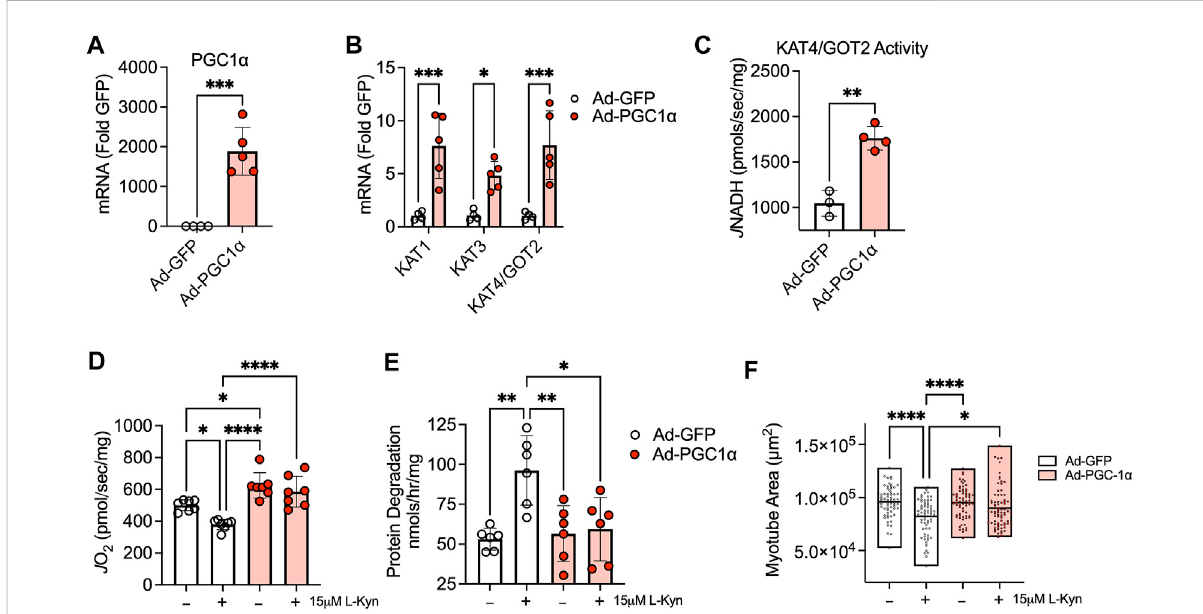
FIGURE 4 Adenovirus-mediated expression of PGC1 α 1 enhances L-Kyn metabolism and protects myotubes for atrophy and mitochondrial de fi cits. (A) Quanti fi cation of mRNA levels of PGC1 α in myotubes infected with adenovirus encoding a GFP (control) or PGC1 α . (B) Ad-PGC1 α expression increased mRNA levels of cytosolic (KAT1 and KAT3) and mitochondrial (KAT4/GOT2) kynurenine aminotransferases. (C) Enzyme activity of KAT4/ GOT2 measured in mitochondrial-enriched lysates from infected myotubes. (D) Mitochondrial oxygen consumption ( J O 2 ) supported by pyruvate, malate, and ADP. (E) Rates myotube protein degradation (tyrosine release) with L-Kyn treatment was prevented Ad-PGC1 α . (F) Quanti fi cation of myotube area (sarcomeric myosin). * p < 0.05, ** p < 0.01, *** p < 0.001 using Student ’ s t -test in panels A – C. * p < 0.05, ** p < 0.01, **** p < 0.0001 using two-way ANOVA with Tukey ’ s posthoc testing. N = 3-7 biologically independent C2C12 lines. Error bars in panels (A – E) represent SD. Panel F shows fl oating bars representing the minimum and maximum values with a line at the